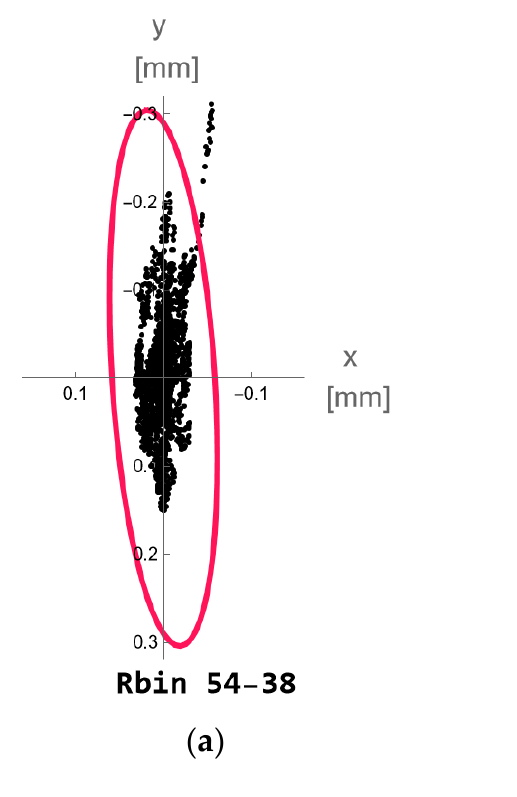
Figure 25. Comparison of total displacements biases between radar and accelerometer measurement with the confidence ellipses (15). Overlay of point clusters (black points) by 95% confidence ellipses (red curves): ( a ) percentage of points in the ellipse that represents accuracy of the displacement vector in R1 Rbin 54 is 98.8%; ( b ) for R1 Rbin 67, the percentage is 95.1%.